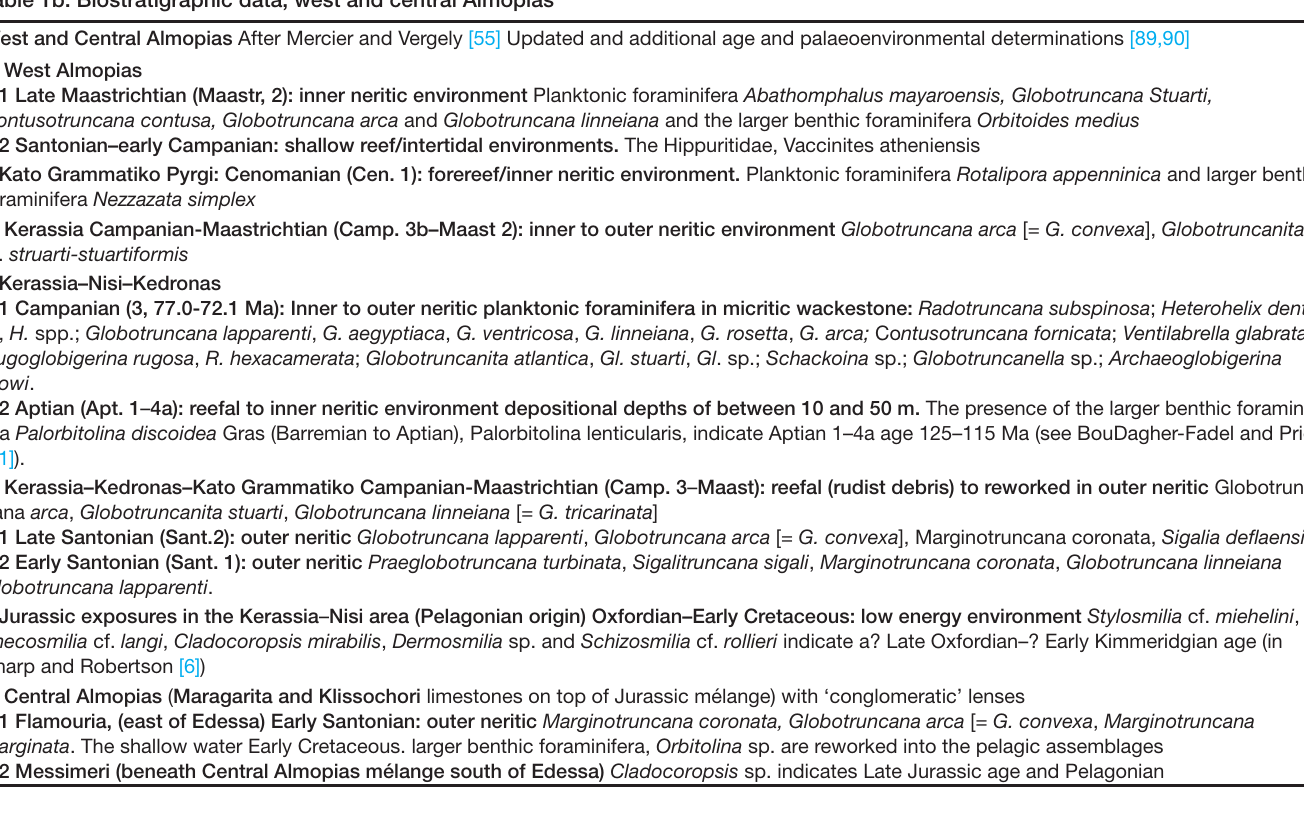
Table 1b. Biostratigraphic data, west and central Almopias West and Central Almopias After Mercier and Vergely [55] Updated and additional age and palaeoenvironmental determinations [89,90] 1. West Almopias 1.1 Late Maastrichtian (Maastr, 2): inner neritic environment Planktonic foraminifera Abathomphalus mayaroensis, Globotruncana Stuarti, Contusotruncana contusa, Globotruncana arca and Globotruncana linneiana and the larger benthic foraminifera Orbitoides medius